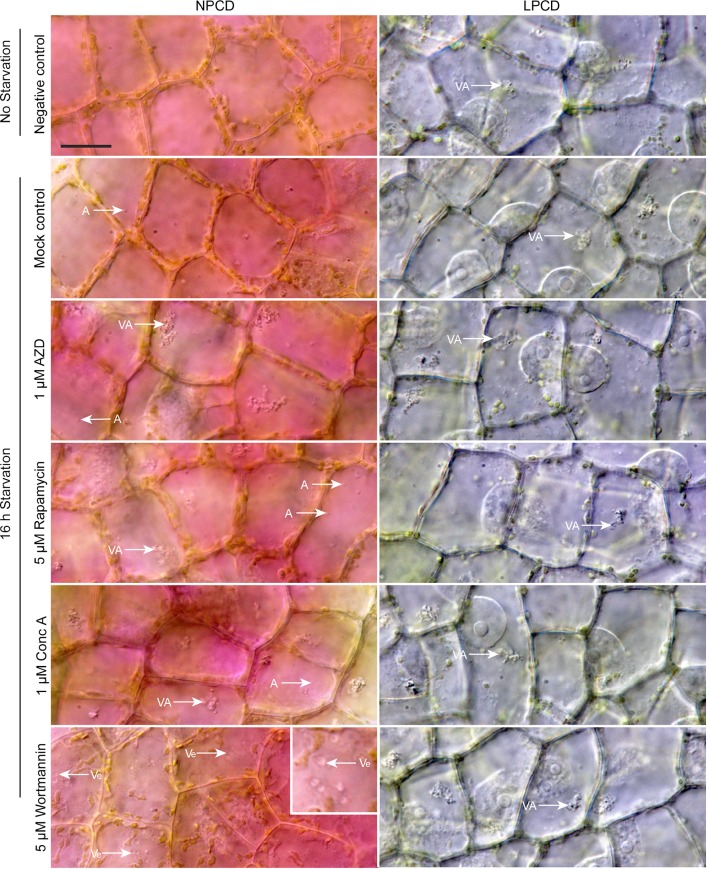
Live cell imaging of non-programmed cell death (NPCD) and late-PCD (LPCD) cells in window stage leaves exposed to various conditions. The negative control was a sample taken directly from plants growing in the culture media. All other treatment groups were subjected to a 16-h starvation period in distilled water prior to 3-h exposure to one of the following: 0.05% DMSO (mock control), 1 µM AZD 8055 (AZD), 5 µM rapamycin, 1 µM concanamycin A (Conc A), or 5 µM wortmannin. VA = vacuolar aggregates, A = autophagosome-like vesicle, inset displays large, organelle-containing vesicles (Ve). n = 3 leaves from individual plants. Scale bar: 20 µm. For additional information see 
Supplementary Files 3
 and 
4
.